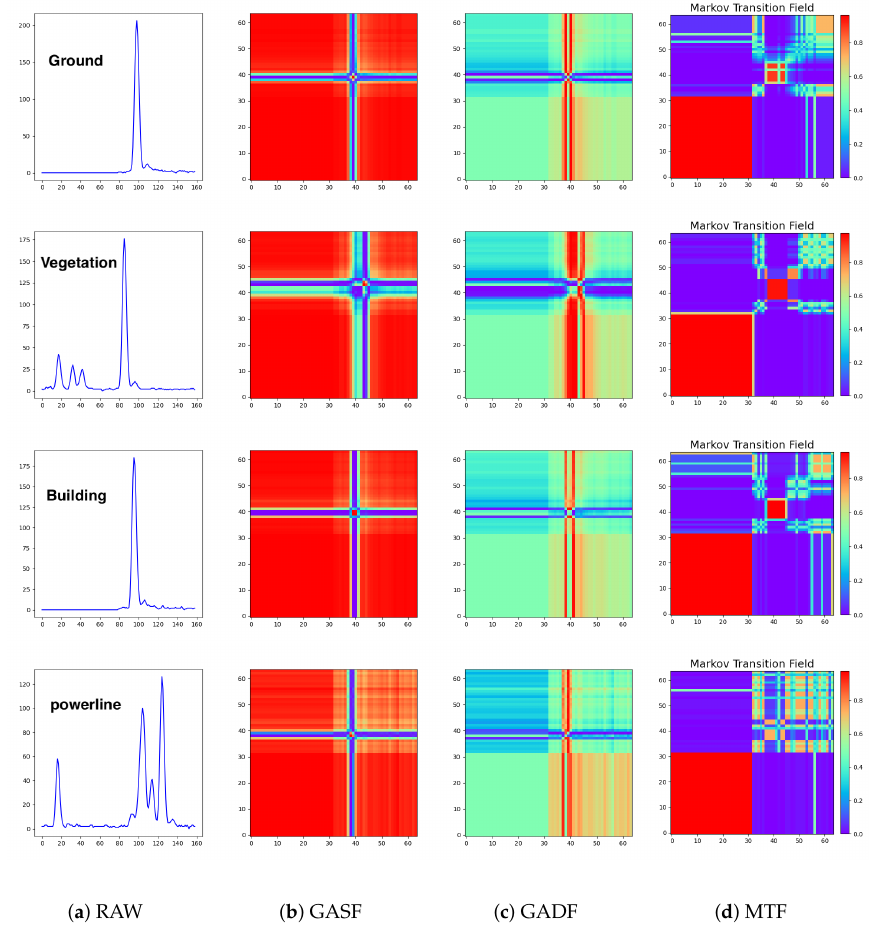
Figure 11. Results of different transform methods used on the urban